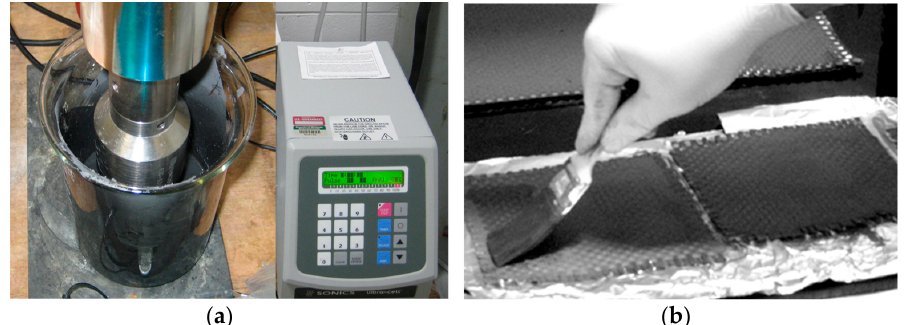
Figure 1. ( a ) Preparation of graphene solution through ultrasonication; ( b ) graphene coating process onto plain weave glass fabric.